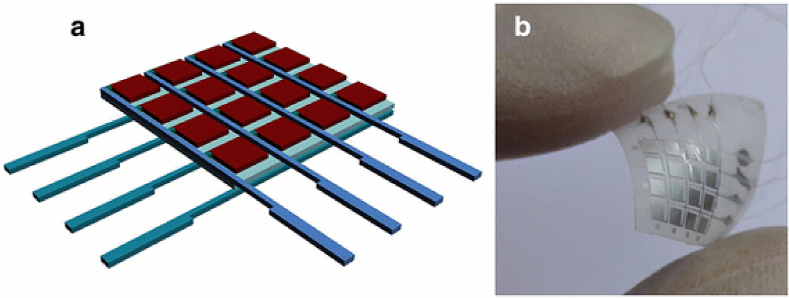
Figure 3. ( a )—schematic diagram of the sensors matrix; ( b )—physical picture of the end device